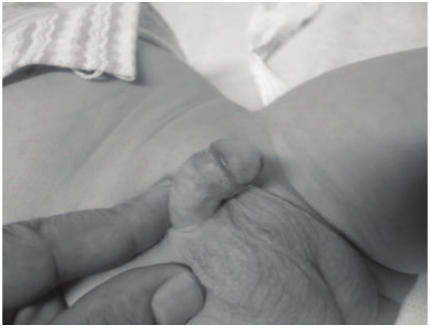
Figure 5: Post operative view after one